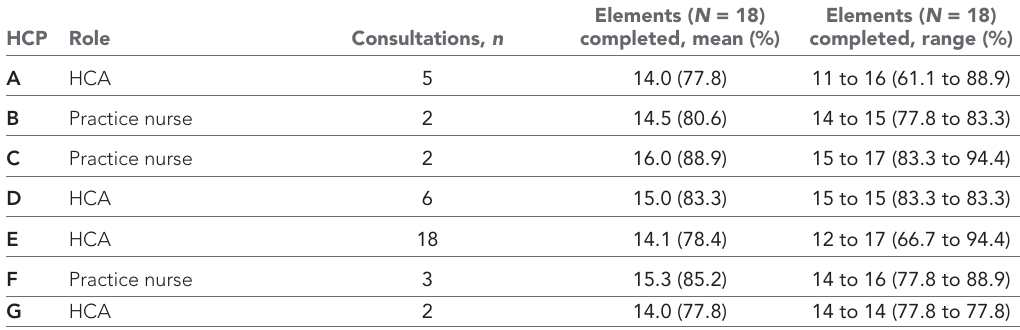
Table 3 Overall fidelity assessment for each HCP